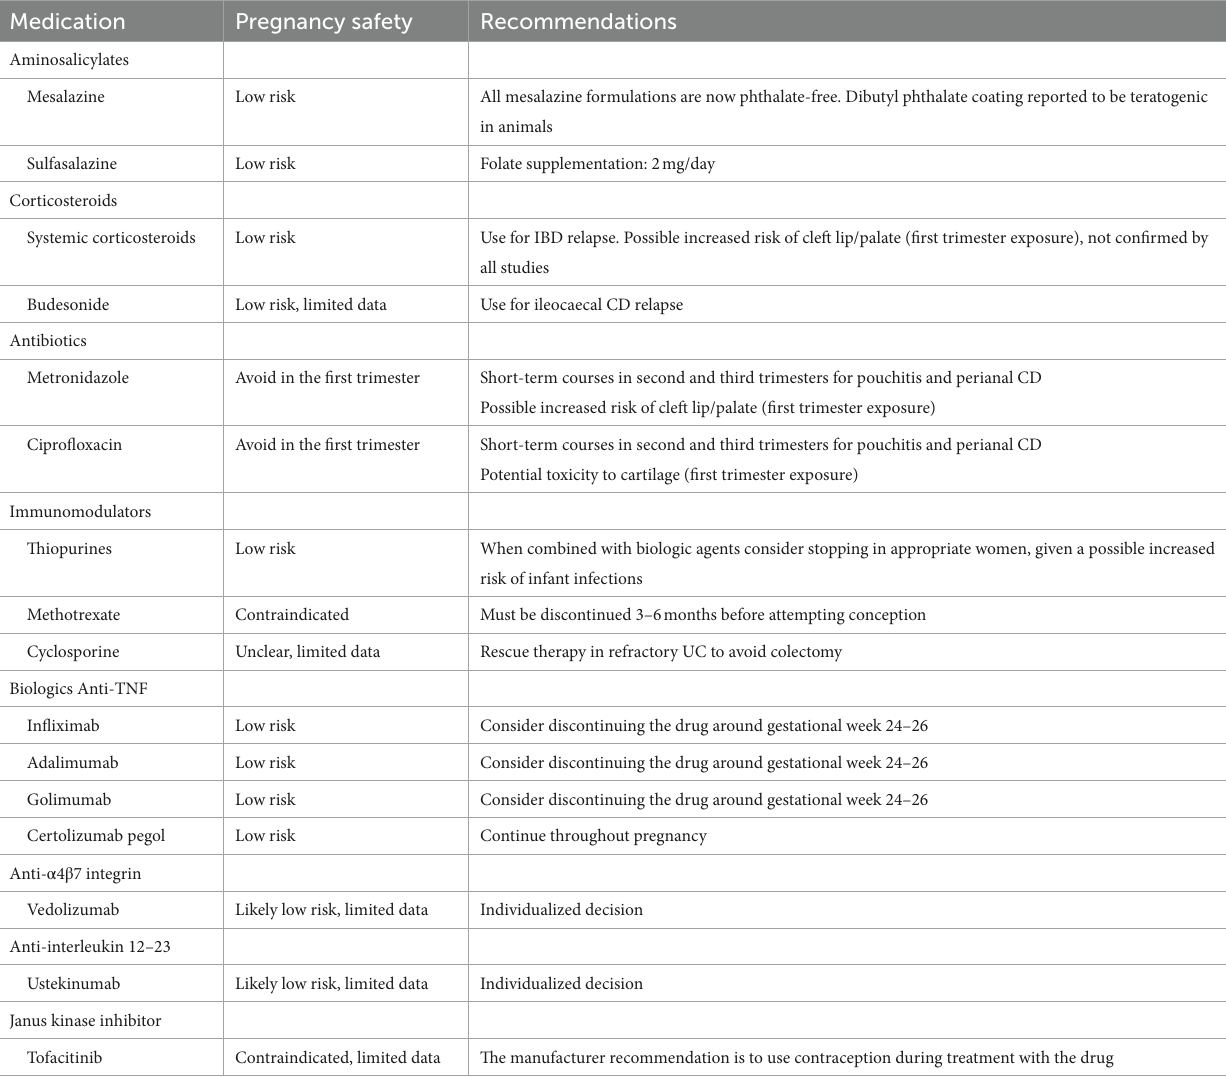
TABLE 1 Medical management of IBD during fertility and